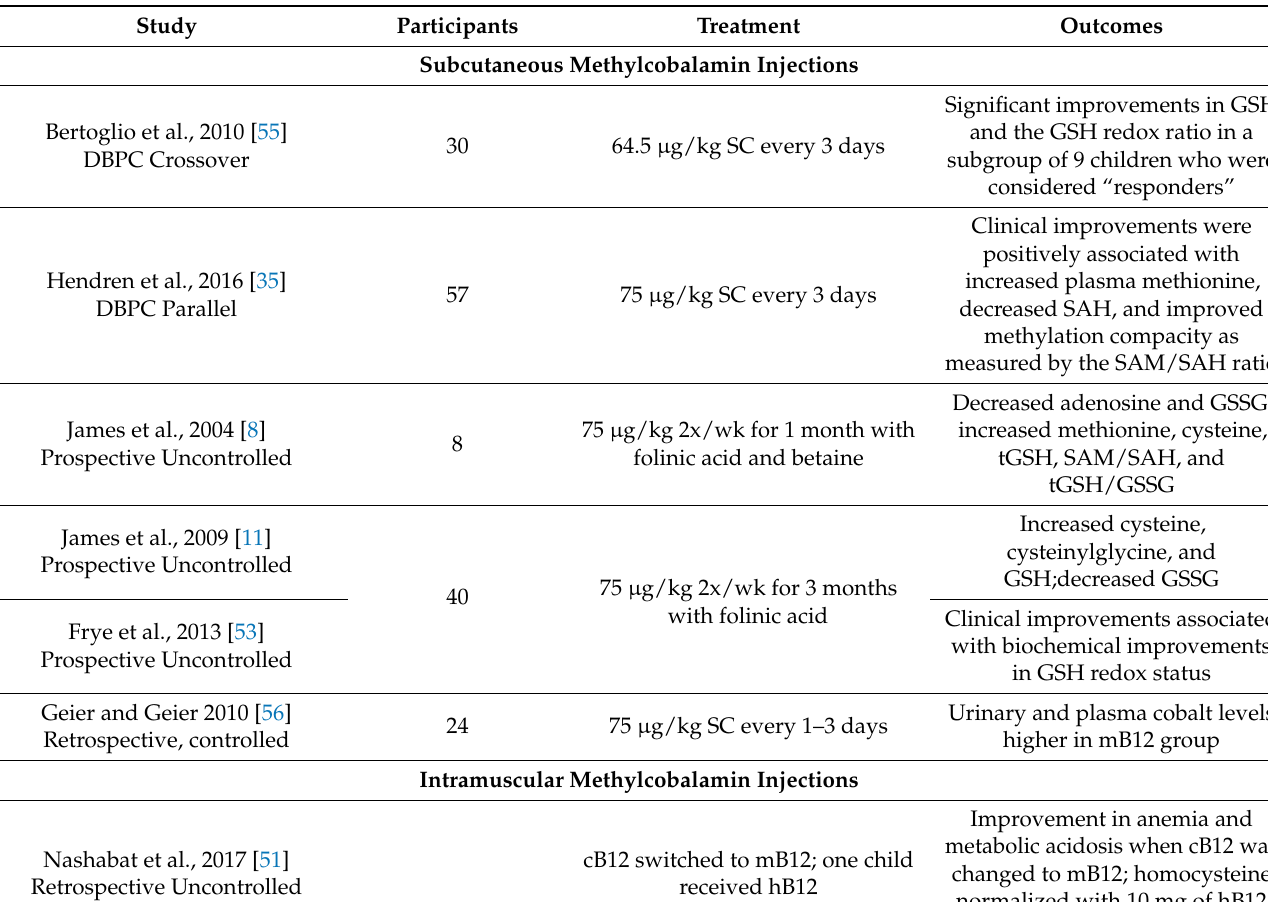
Table 2. Biochemical outcomes for treatment studies of cobalamin injections for autism spectrum disorder. Clinical global impression scale (CGI); subcutaneous (SC); years old